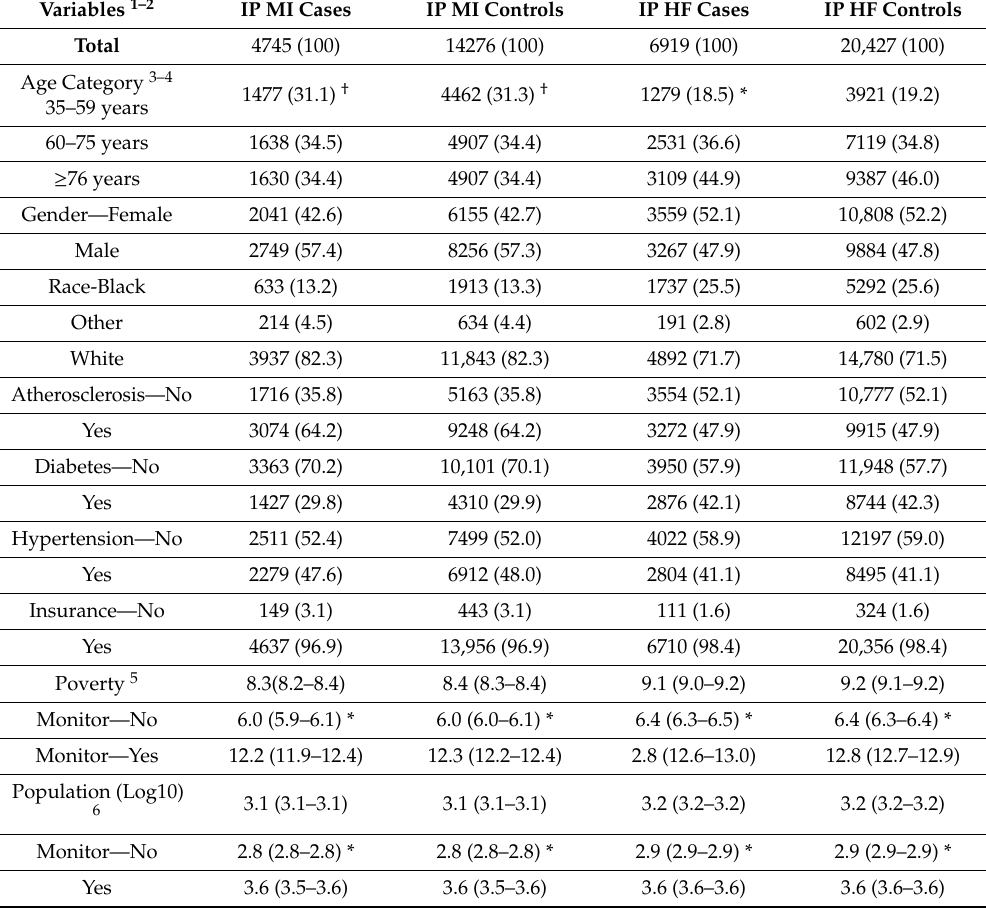
Table 2. Demographics for IP Myocardial Infarction (MI) and IP Heart Failure (HF) Cases and Controls in the Baltimore